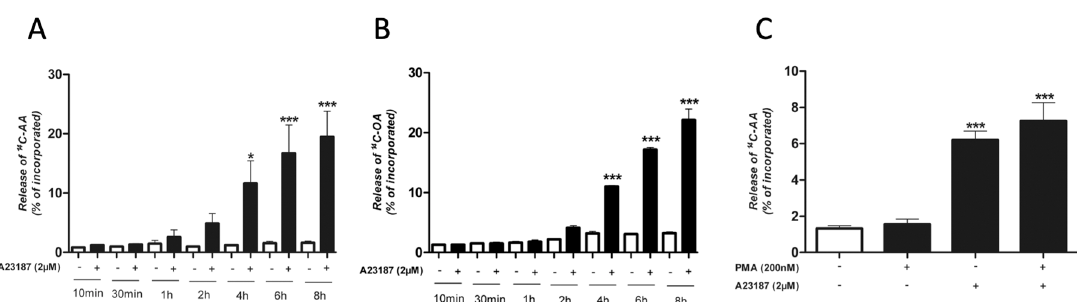
Figure 3. Release of radiolabeled fatty acids from A23187-stimulated HMC-1 cells. Control cells were incubated with culture medium only. ( A ) Time-dependent release of arachidonic acid (AA). ( B ) Time-dependent release of oleic acid (OA). ( C ) E ff ect of combined stimulation with calcium ionophore A23187 and phorbol myristate acetate (PMA) on the release of AA. PMA and / or A23187 were added for 4 h. * p < 0.05, ** p < 0.01, *** p < 0.001 vs. control cells. Data from three independent experiments.